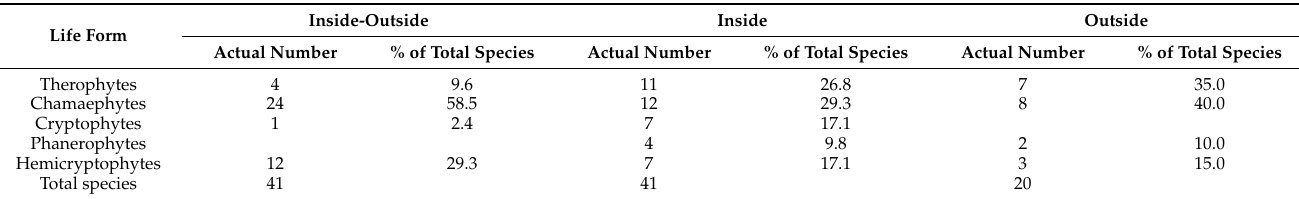
Table 3. Biological spectrum of the recorded species both inside and outside (inside-outside), only inside, and only outside the protected enclosures.